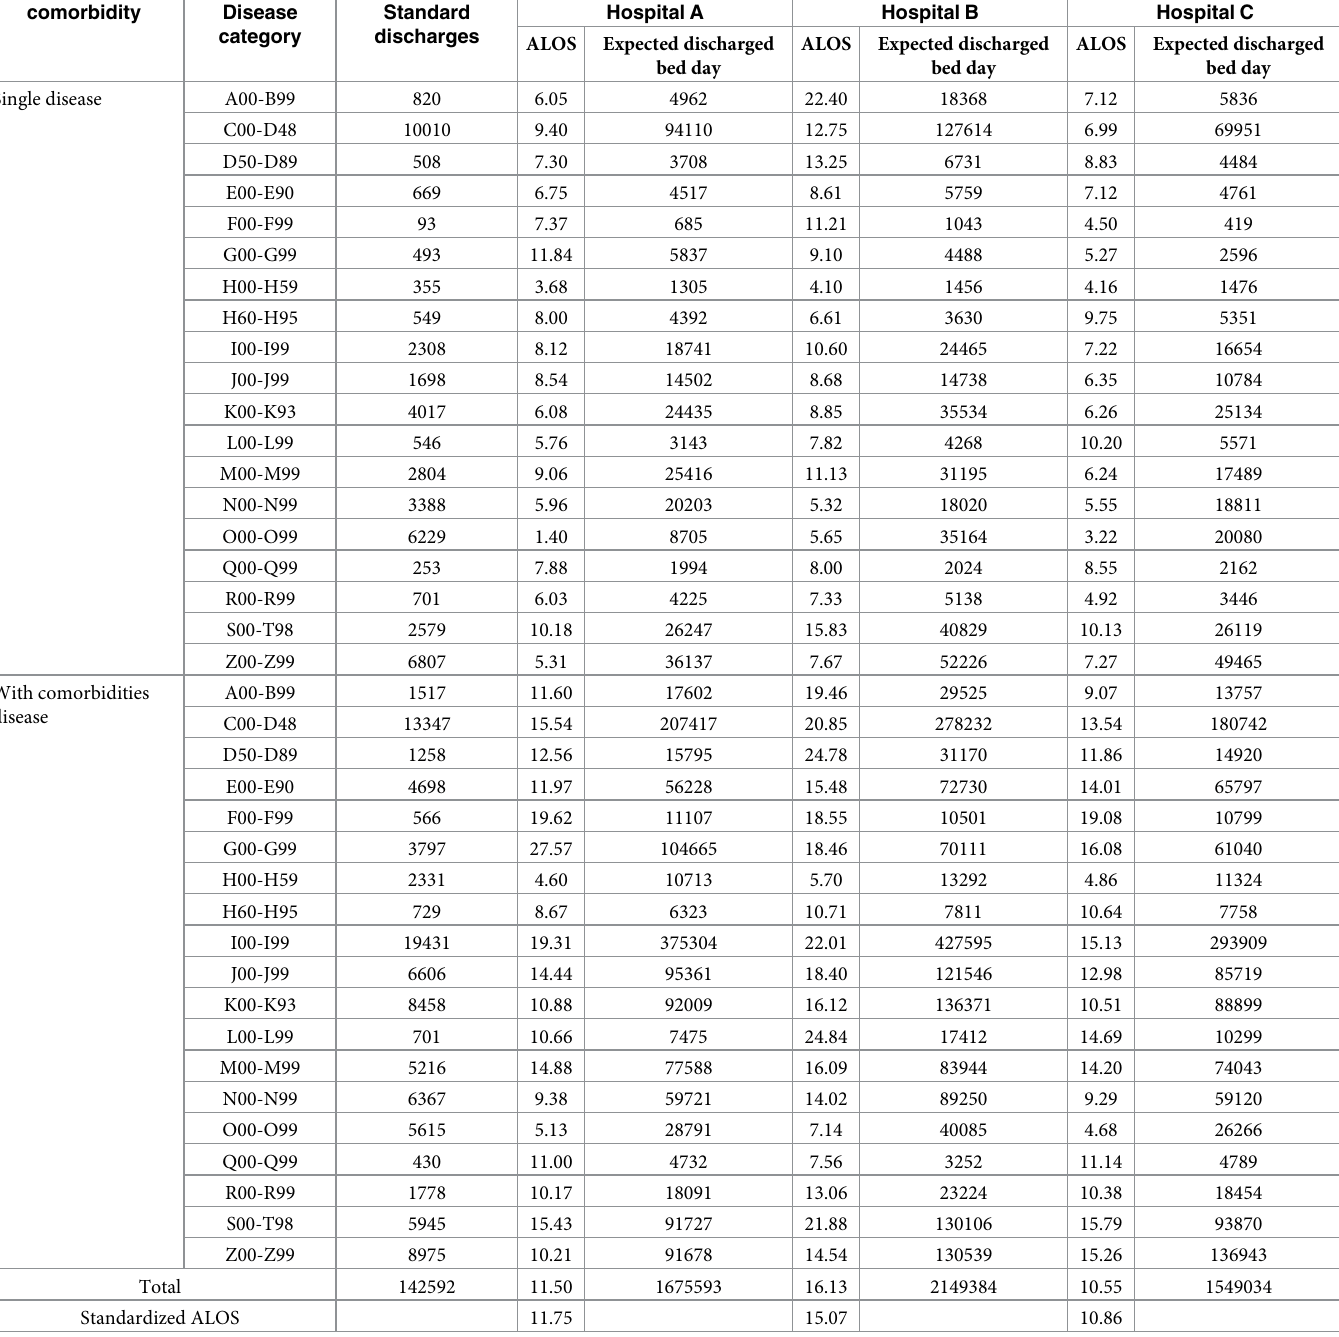
Table 6. The standardized ALOS by disease category and comorbidity among three hospitals. comorbidity Disease category Single